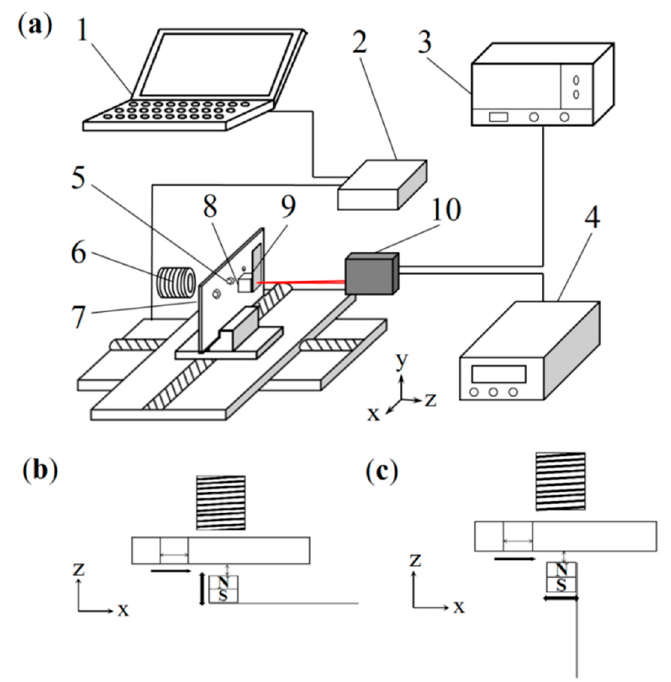
Figure 3. ( a ) Experimental setup: 1. Computer; 2. Moving stage controller; 3. Oscilloscope; 4. Direct-current power supply; 5. Defect (mimicked by the through-holes); 6. Exciting coil; 7. Test sample; 8. PM; 9. Cantilever; 10. Laser displacement sensor. During the experiment, the test sample moves in the x -direction while displacement of cantilever is measured; ( b ) Setup for measuring the z -direction force; ( c ) Setup for measuring the x -direction force.